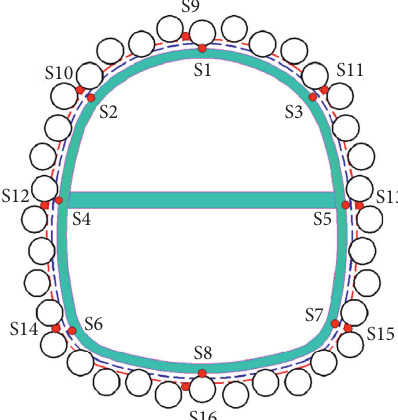
Figure 24: Layout of in situ monitoring points for the water pressure outside the tunnel.